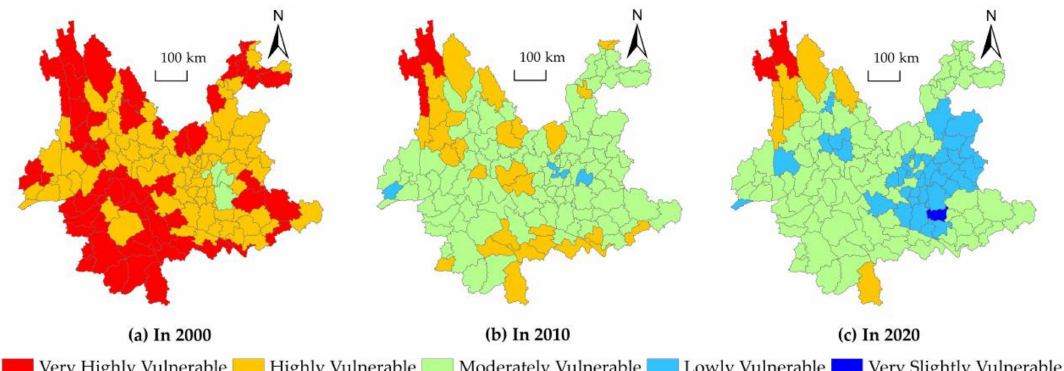
Figure 5. Economic vulnerability evaluation of rural areas in Yunnan Province from 2000 to 2020.